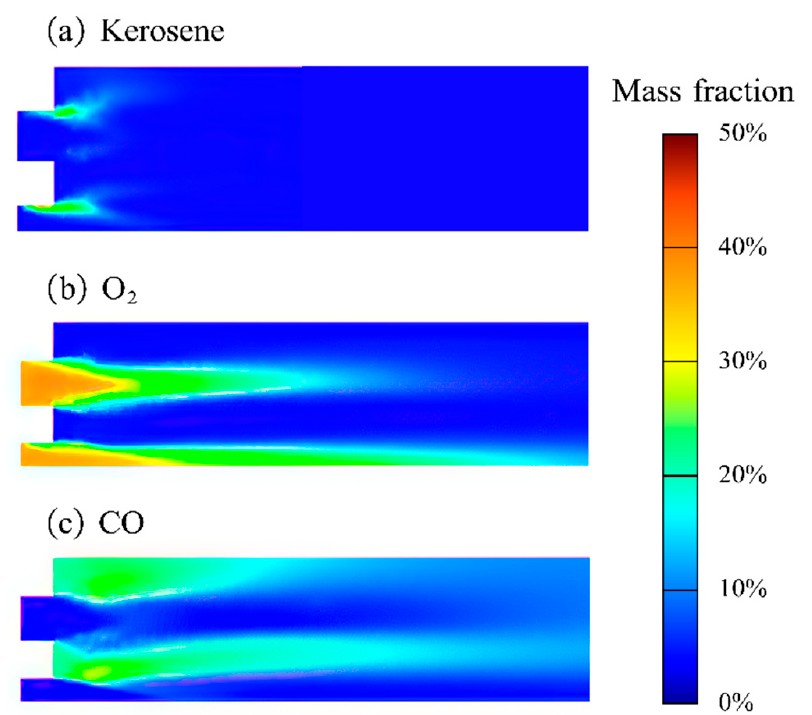
Figure 11. Contours of the component mass fraction. ( a ) Contour of the kerosene inside the combustion chamber; ( b ) contour of the O 2 inside the combustion chamber; ( c ) contour of the CO inside the combustion chamber.